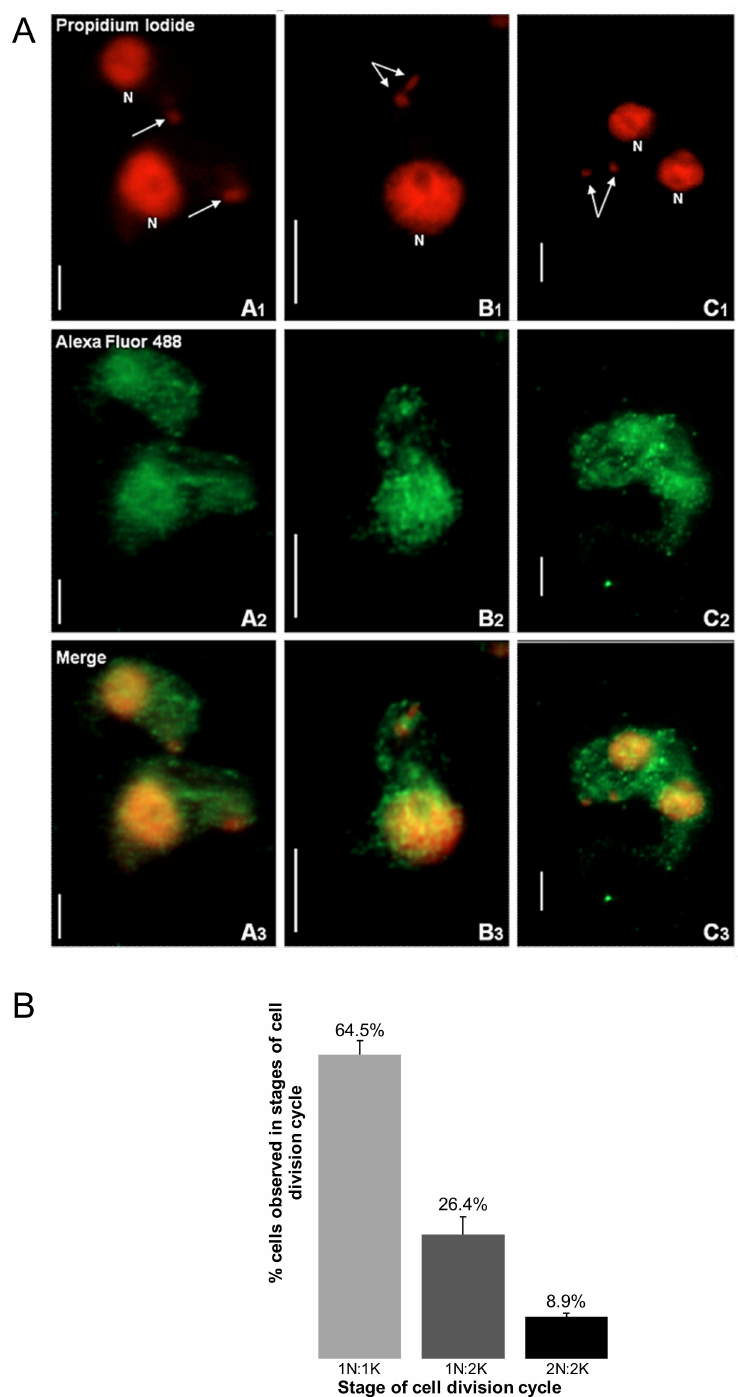
Figure 2. The distribution of TbHsp70.c is cytosolic and nucleic along the T. brucei life cycle. ( A ) Mor- phology of the kinetoplast at different stages of the T. brucei bloodstream form cell cycle. The top row represents the propidium iodide signal in enlarged images of the number and location of nu- clei (N) and kinetoplasts (arrow). Upright scale bar, 5 µ m. Columns: A—cells have 1 nucleus and 1 kinetoplast (1N:1K); B—1N:2K; C—2N:2K. Rows: Propidium iodide—parasite DNA detected with a UV filter, shown in red; Alexa Fluor 488—localization of TbHsp70.c; Merge—amalgamated image of DNA staining and TbHsp70.c localization. ( B ) The percentage T. b. brucei cells counted containing 1N:1K, 1N:2K and 2N:2K. Error bars represent the standard deviation between two